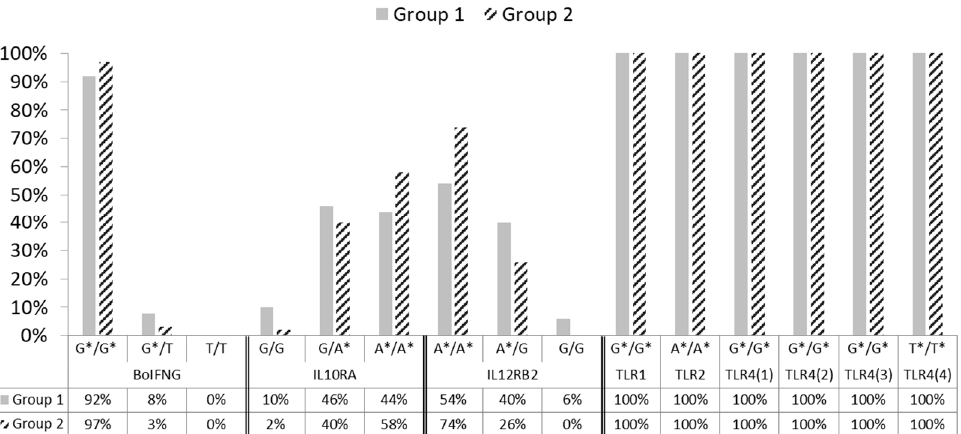
Figure 1. Histogram plot highlighting genotype frequency differences, between groups 1 and 2, for target gene polymorphisms investigated in the study; * Alleles associated with PTB resistance.